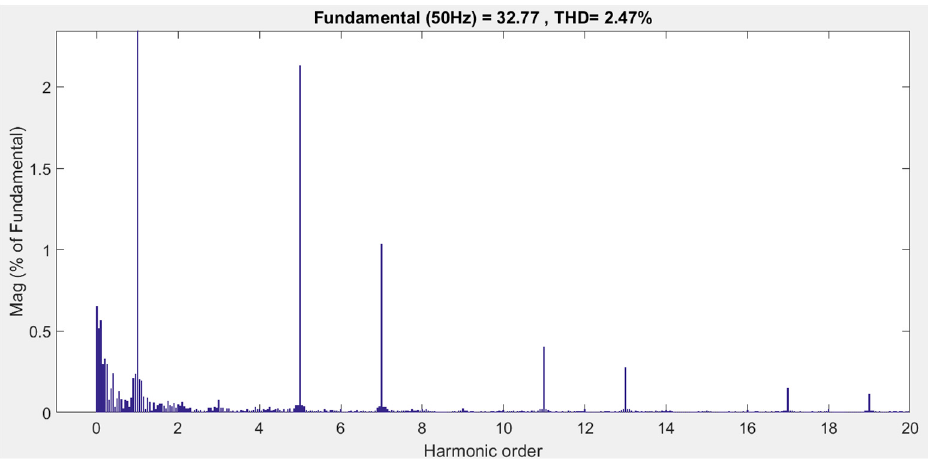
Figure 17. Harmonic diagram of load current with PV inverter.